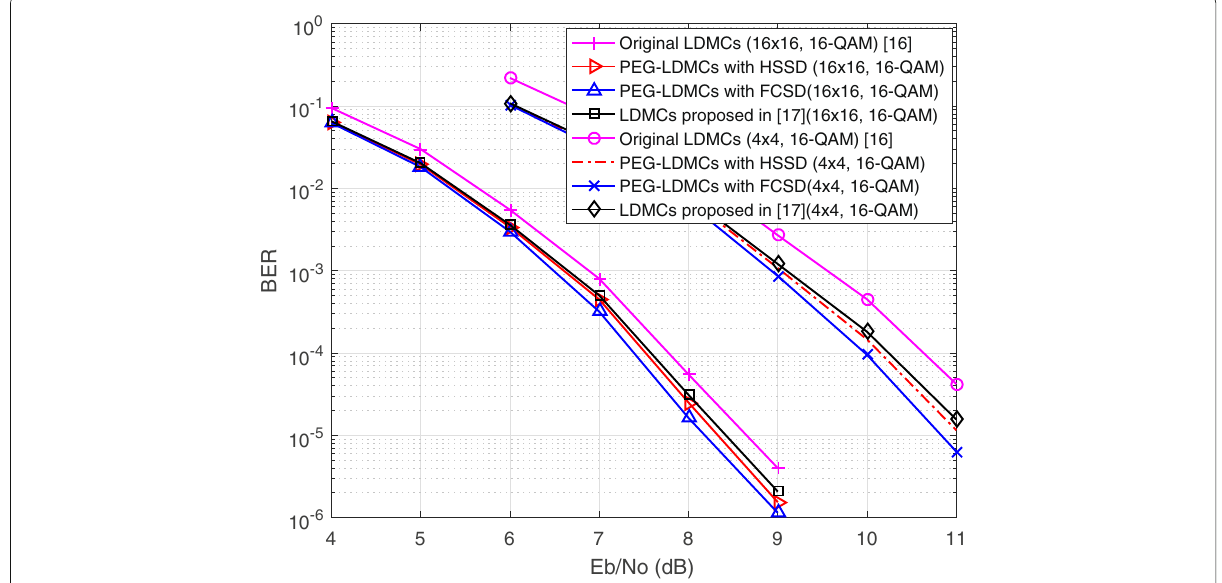
Fig. 3 BER performance comparison of PEG-LDMCs, LDMCs proposed in [17] and original LDMCs in [16] with 4 × 4 MIMO and 16 × 16